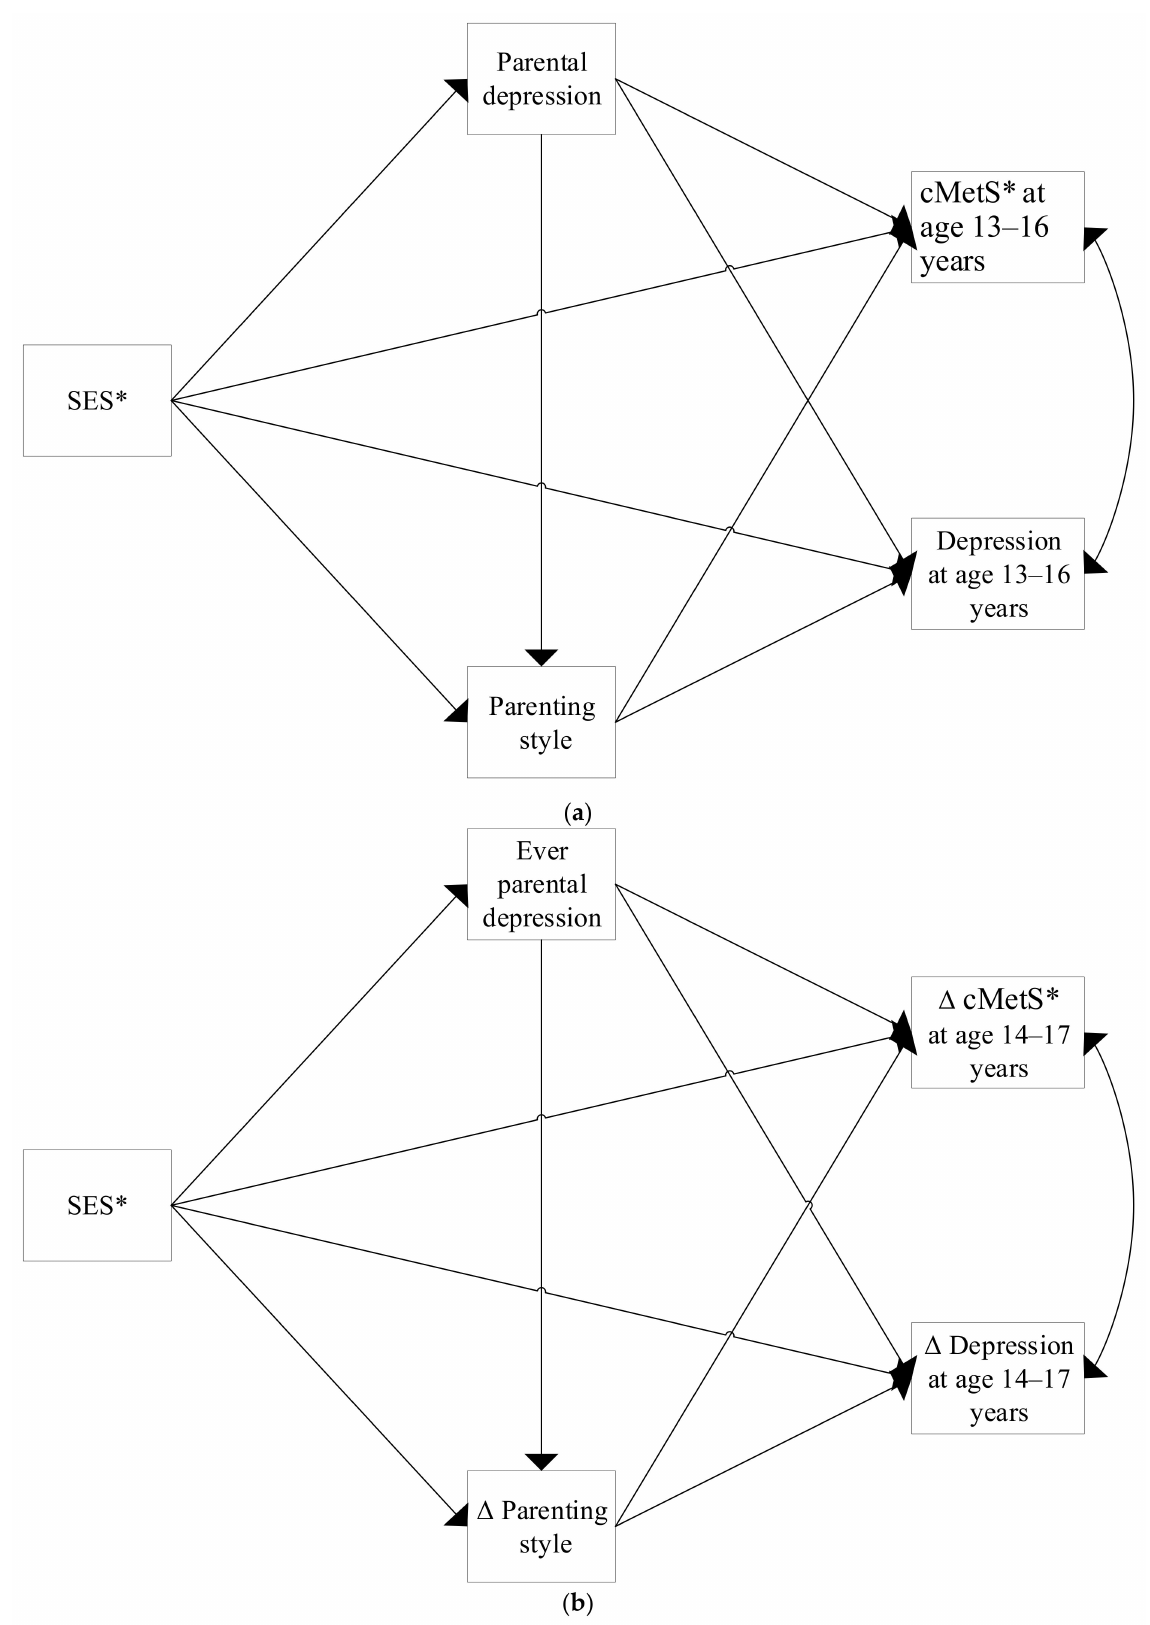
Figure 1. Theoretical model demonstrating the direct and indirect pathways connecting SES to both ( a ) baseline values and ( b ) changes in depression and MetS. * Separate models were estimated for each proxy of SES (education, income, and occu- pation). Additionally, sensitivity analyses were conducted using BMI and ∆ BMI instead of cMetS and ∆ cMetS,